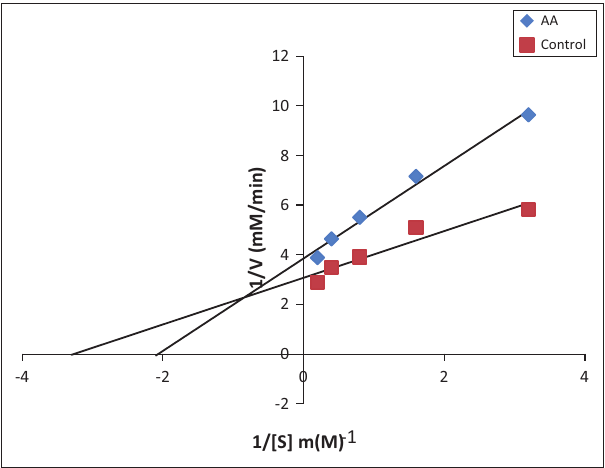
FIGURE 9: Lineweaver–Burk plot of acetone extract of leaves of Acalypha godseffiana eliciting mixed non-competitive inhibition on α-amylase activity. Results = mean ± SEM ( n = 3); ( p < 0.05). AA, A. godseffiana acetone leaf